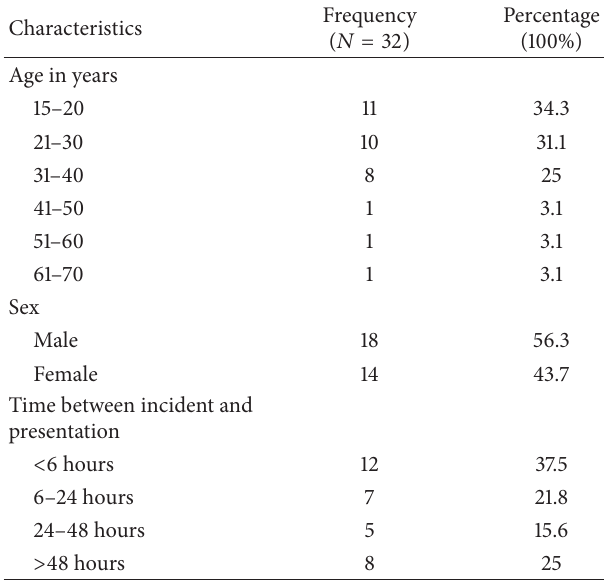
Table 1: Sociodemographic features of patients who underwent foreign body extraction at Tikur Anbessa Hospital,